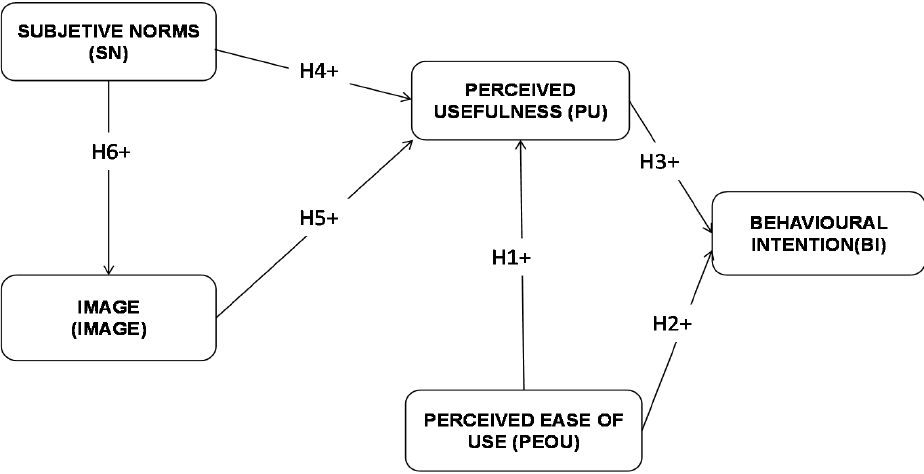
Figure 1. Proposed microblogging acceptance model